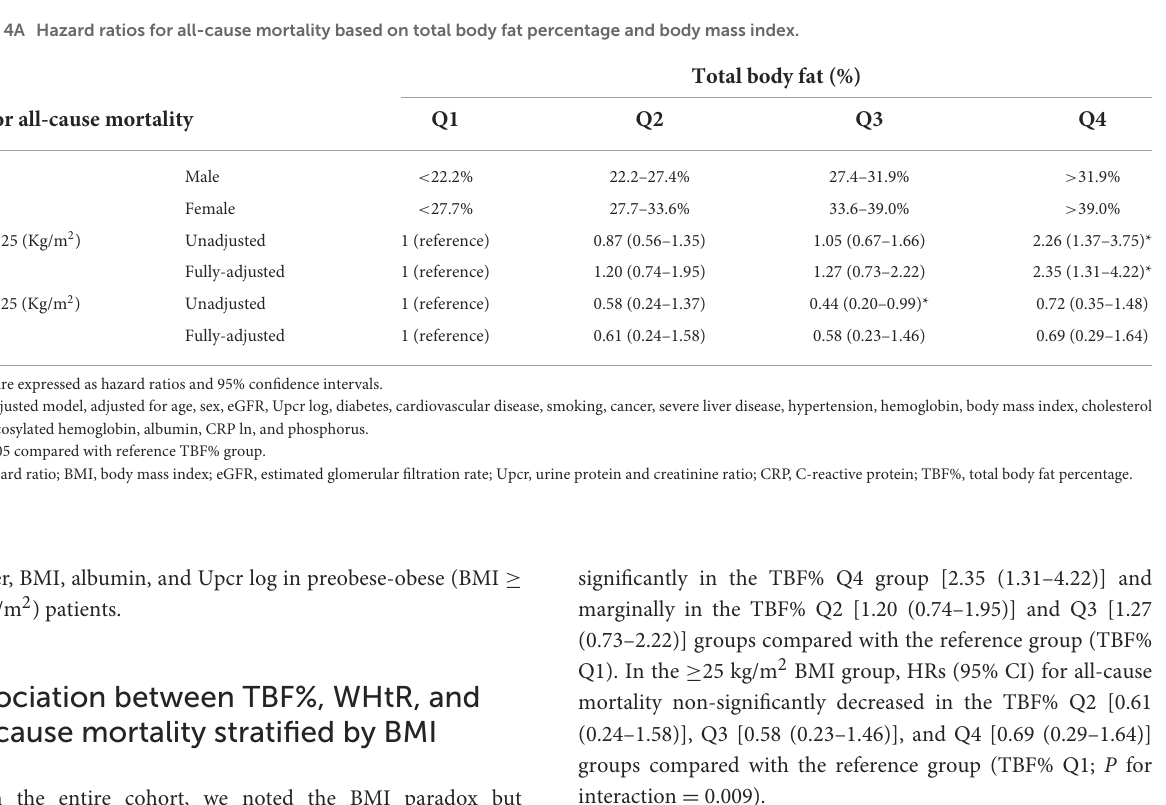
TABLE 4A Hazard ratios for all-cause mortality based on total body fat percentage and body mass index.